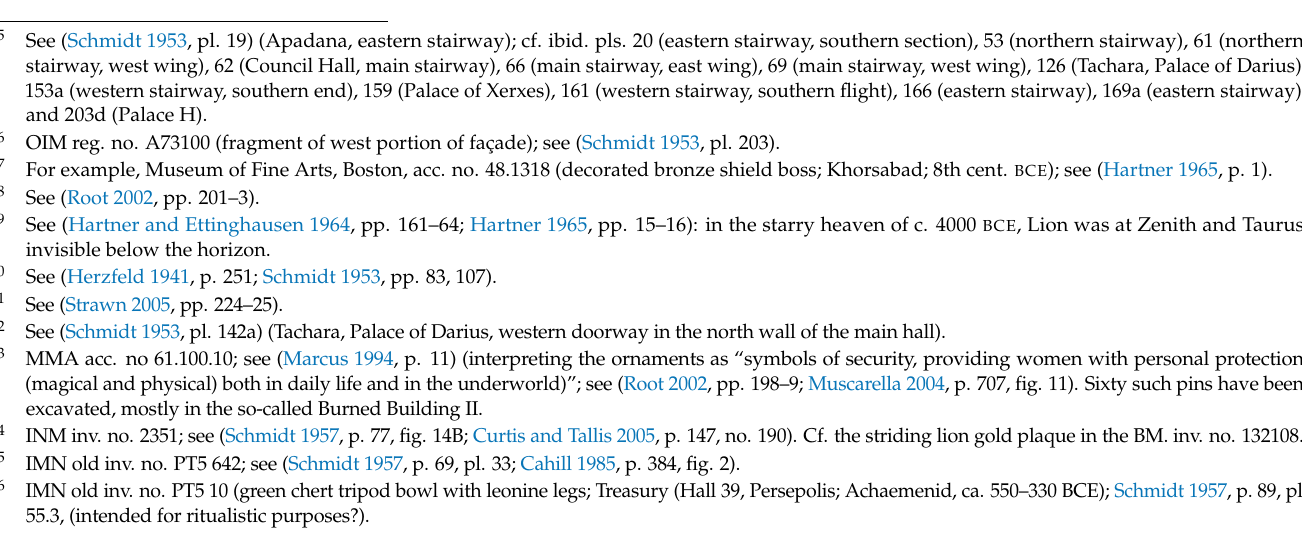
Figure 21. Lion attacking bull (OIM reg. no. A73100); relief panel, fragment; Palace H, Persepolis, Persia (mod. Iran); Achaemenid, ca. 404–358 BCE [photography by Michael Tropea; courtesy of the Oriental Institute Museum Chicago].